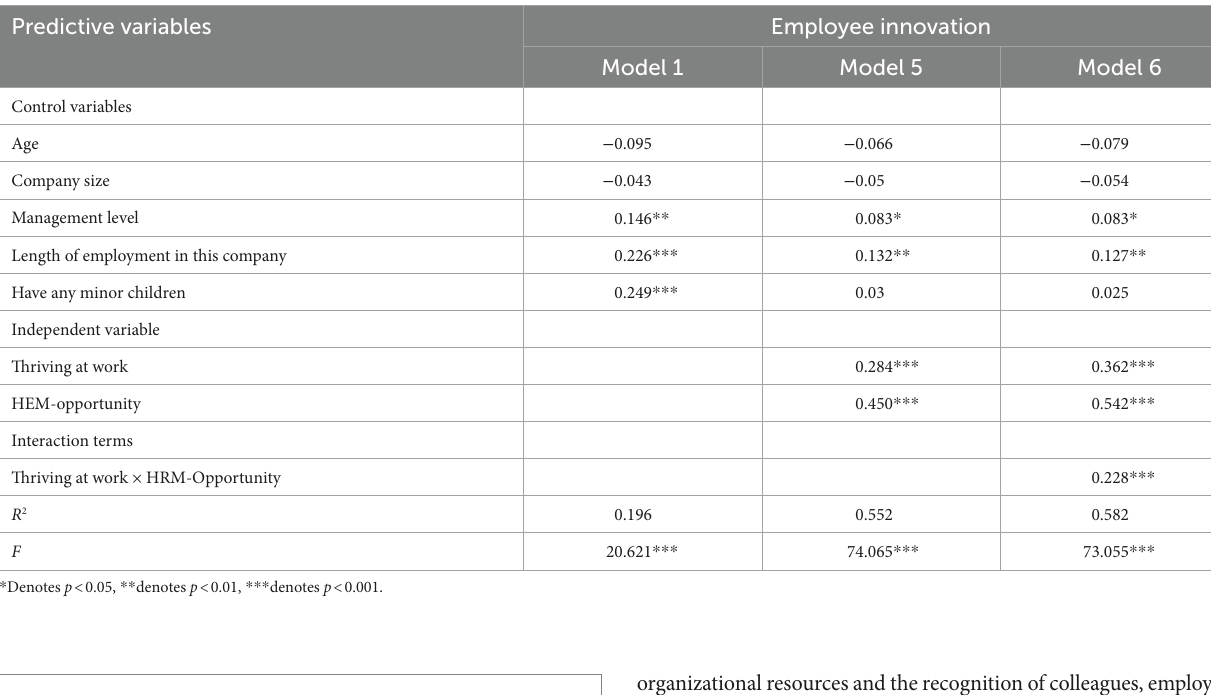
TABLE 7 Results of the test for moderating effects.